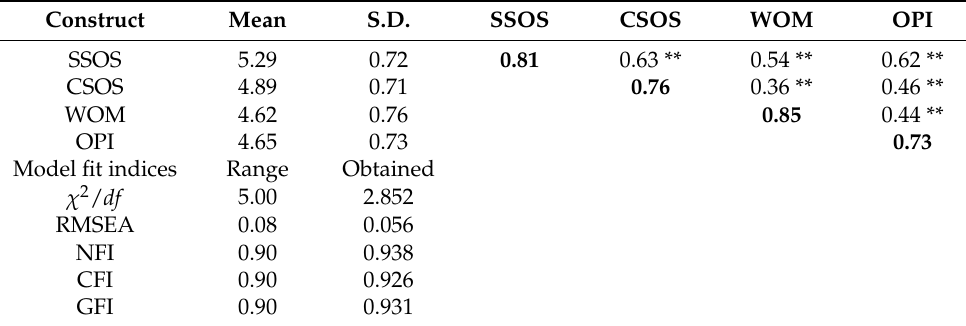
Table 3. Correlation, discriminant validity, and model fit indices results.